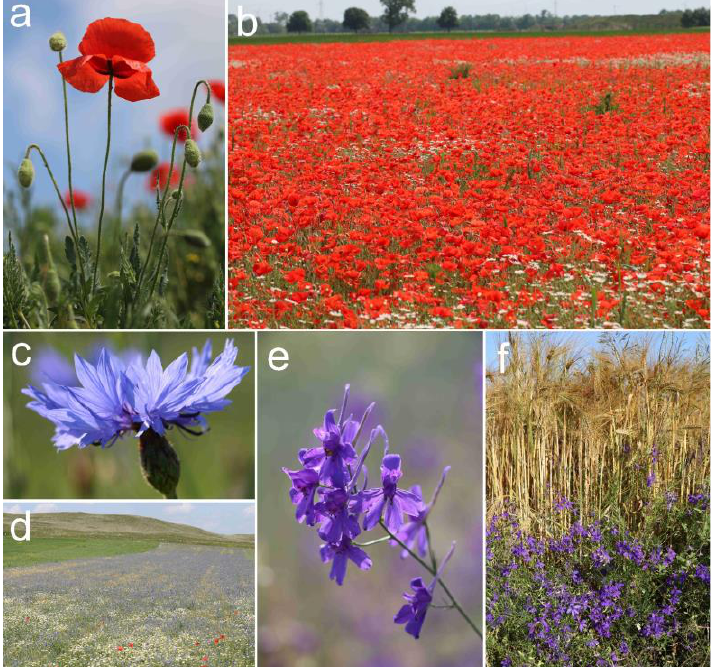
Figure 1. The three studied weed species and their spectacular mass occurrences in arable fields: ( a , b ) Papaver rhoeas (Hegyeshalom, NW-Hungary, 2018); ( c , d ) Centaurea cyanus (Öskü, W-Hungary, 2011); ( e , f ) Delphinium consolida (Püski, NW-Hungary, 2020; all photographs by Gyula